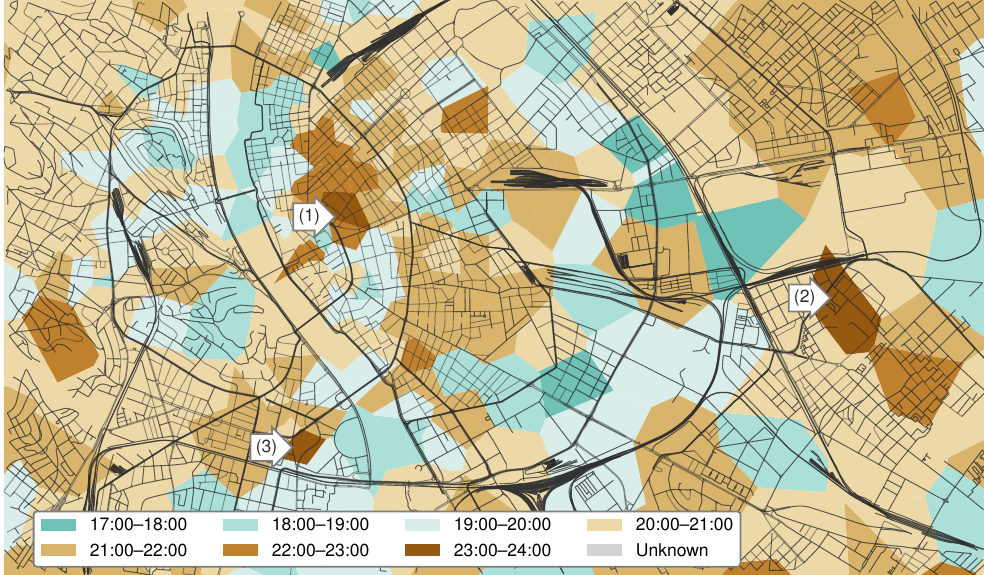
Figure 14. Spatial distribution of the cell-based bedtimes, aggregated to sites. This procedure can be applied for every cell (or group of cells, such as sites), then the activity of the workers and the inhabitants will represent the workplace and home activity tendencies. Note that a cell can have both workers and inhabitants, so every cell has two aspects. Figure 16a,b illustrates the activity of the subscribers who work and live a selected site, respectively. Figure 16a also demonstrates the concept of Figure 7, using actual data. As expected, Figure 16a,b is in accord with Figure 15a,b. The workers’ activity increases in the morning and decreases late in the afternoon, whereas the inhabitants’ activity decreases in the morning, increases late in the afternoon and reaches its peak in the evening. The two aspects of the same site have the opposite